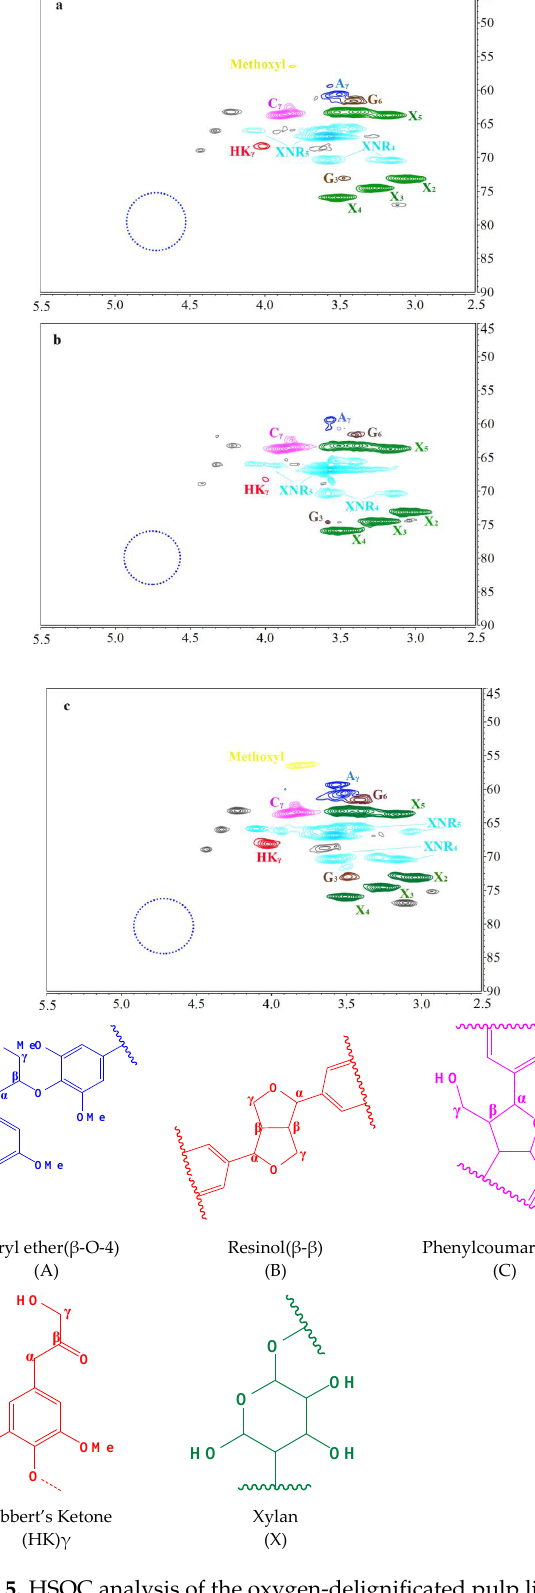
Figure 5. HSQC analysis of the oxygen-delignificated pulp lignin with or without IL pretreatment: ( a ) lignin in control pulp, ( b ) lignin in [BMIM] [HSO 4] pretreated pulp, and ( c ) lignin in [TEA] [HSO 4 ] pretreated pulp. (A) β -O- 4 ether bond; (B) β - β resinol bond; (C) β -5 phenylcoumarin bond; (HK) Hibbert’s ketone; (X) xylan.